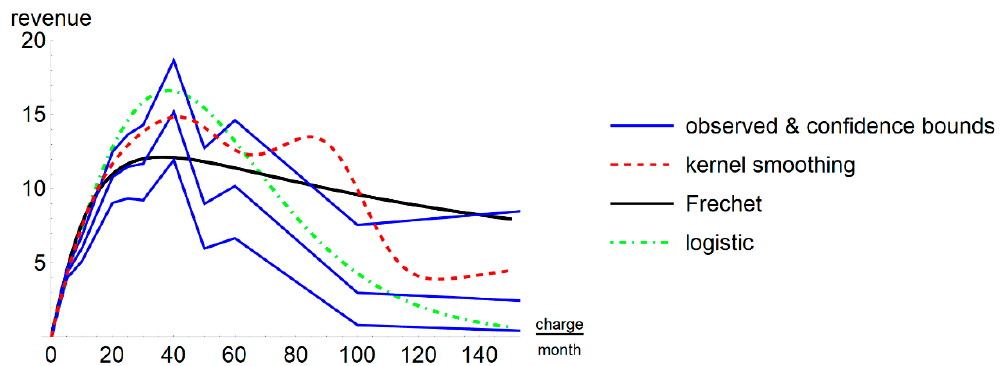
Figure 12. Expected monthly revenues per HH from a sewerage charges x INR per HH under a conservative assumption for cost recovery (100 data, 2015 Raisen survey) and expected revenues under various distribution assumptions for WTP: observed frequencies and one-sided 95% confidence limits (blue, based on the Appendix, formula (3)), smooth-kernel distribution (dashed red), Frechet distribution (black), and logistic distribution (dot-dashed green). Plot and computations using Mathematica 11.3.